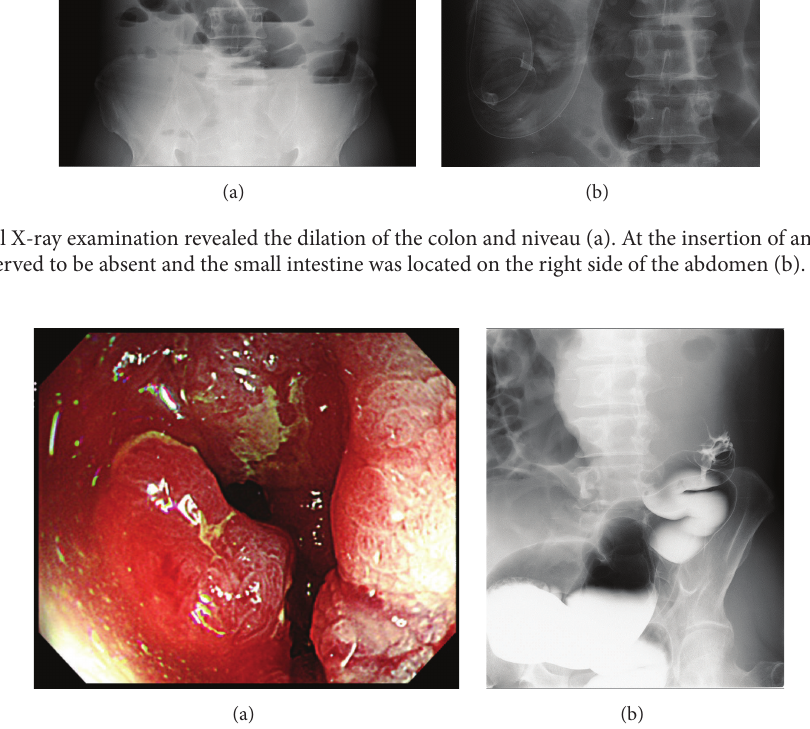
Figure 2: Colonoscopy revealed an advanced tumor in the descending colon (a). An opaque enema using contrast fluid revealed severe stenosis of the descending colon. The contrast fluid could not pass the stenotic part of the descending colon